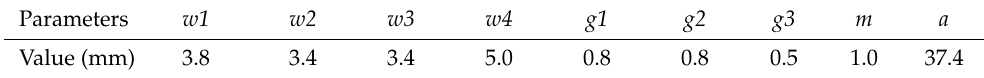
Figure 6. Geometric layout model of the optimised four-turn split-ring loop.